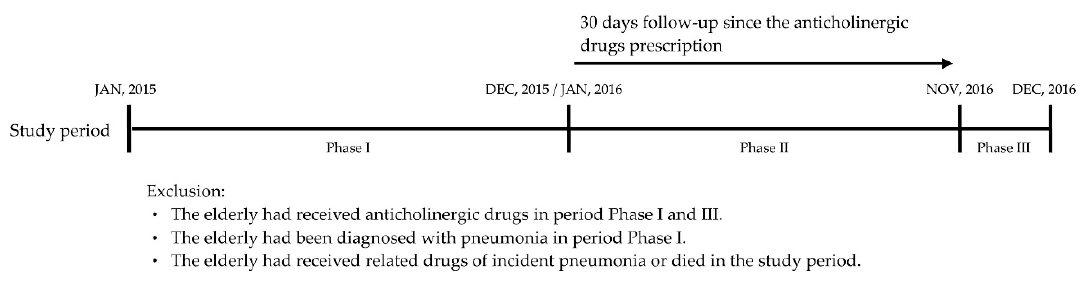
Figure 2. The study design diagram.